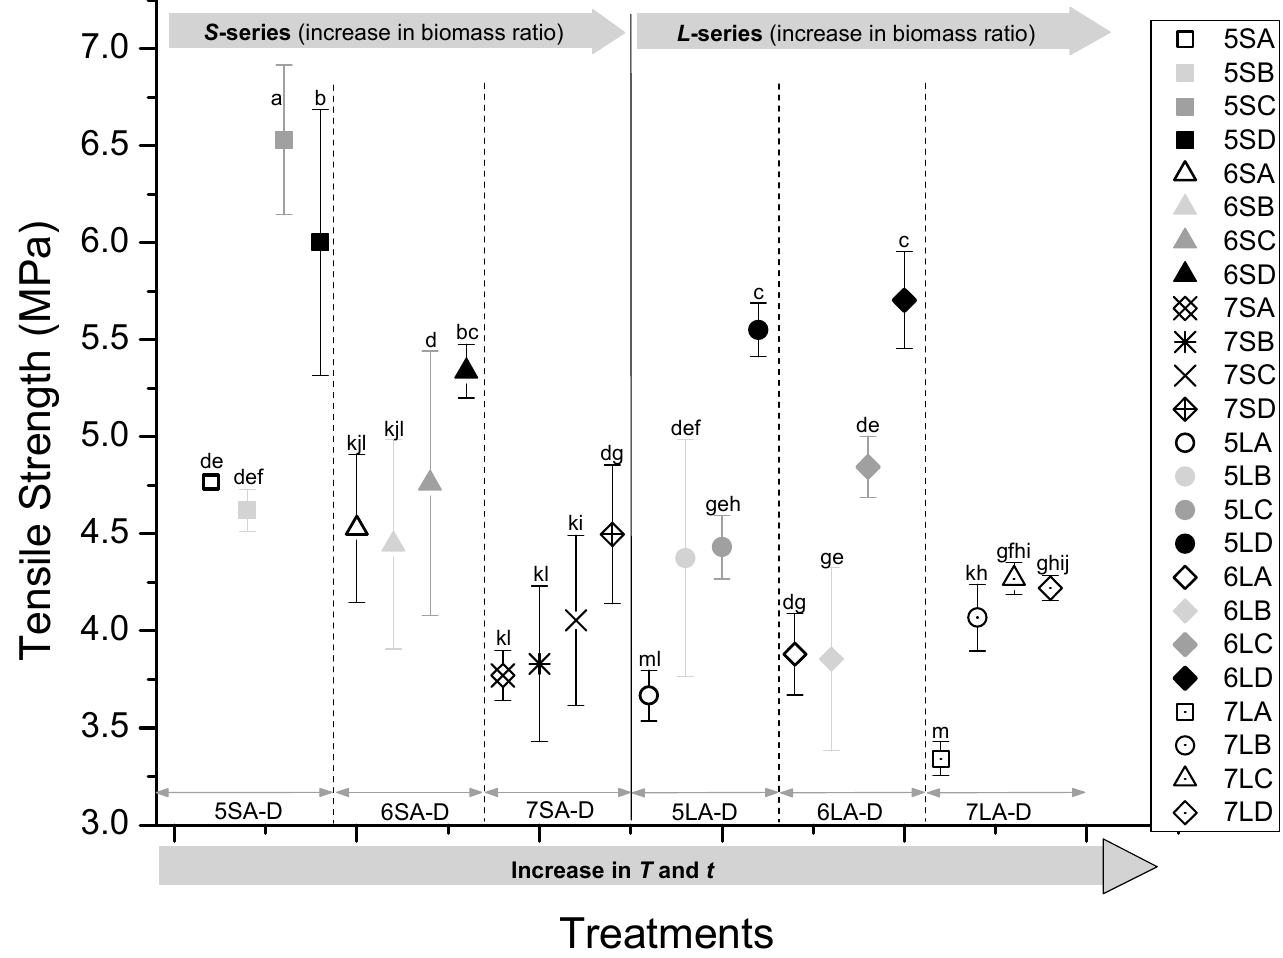
Figure 12. Tensile strength of the WPCs pressed at different temperatures and times (A–D) with 50, 60, and 70% biomass at two particle sizes ( S and L ). Symbols with the same letters are not significantly